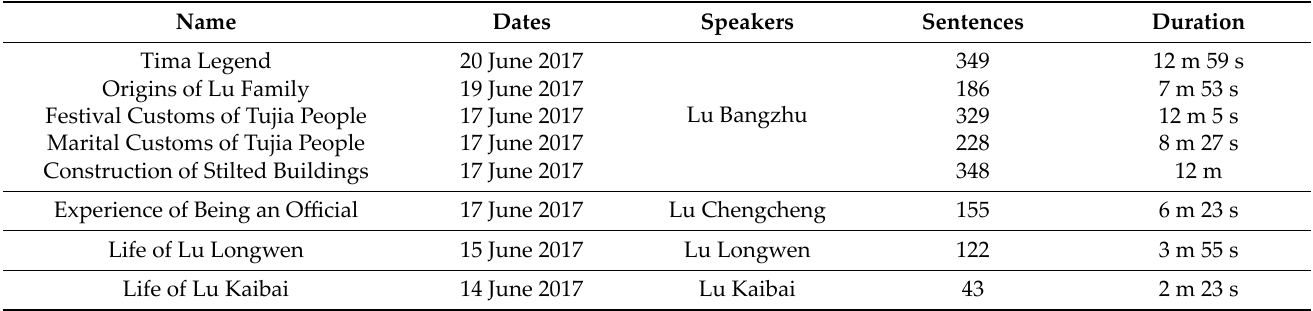
Table 1. Datasets of Tujia language.